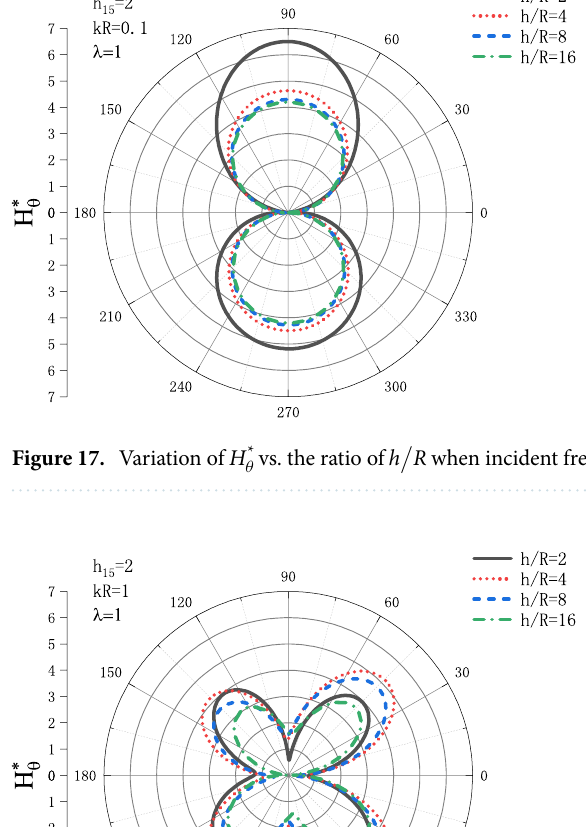
* θ vs. the ratio of